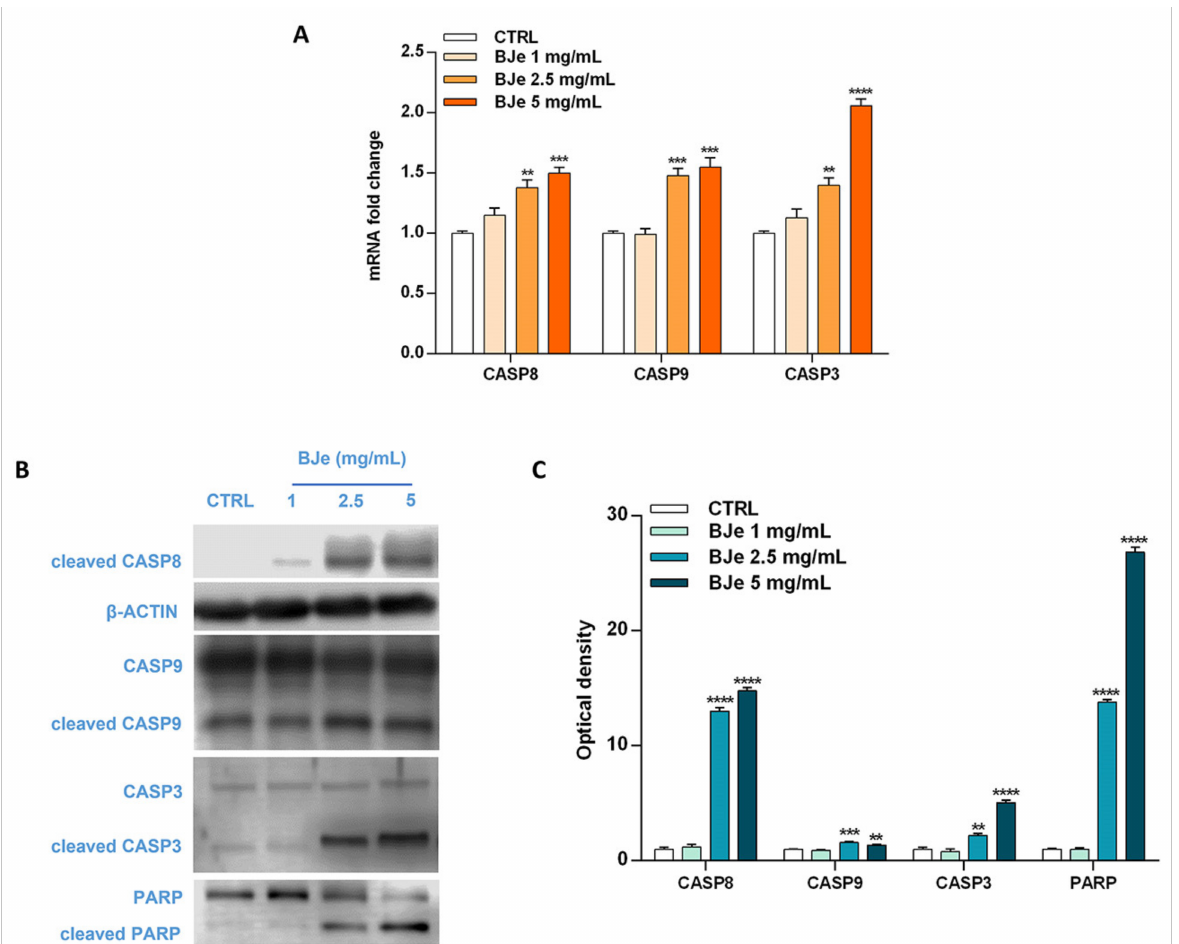
Figure 6. Gene and protein expression of apoptosis-related factors modulated by BJe in THP-1 treated cells. Cells were exposed to different concentrations (1–5 mg/mL) of BJe for 12 h and 24 h and were processed for gene and protein expression studies, respectively. The gene expression was calculated by the 2 – ∆∆ CT method, with β -actin as housekeeping gene. Results are expressed as fold change compared to the untreated cells ( A ). A representative immunoblot of three independent experiments is shown ( B ). Densitometric analysis of bands from three independent blots is presented ( C ). Results are expressed as ratio of the cleaved form with respect to the relative zymogen (cleaved CASP9/CASP9, cleaved CASP3/CASP3 and cleaved PARP/PARP), while the expression of cleaved CASP8 was normalized against β -actin. Protein levels are extrapolated as values detected in the untreated cells (CTRL), which are arbitrarily assigned as 1. Data, represented as mean ± SEM, report the values obtained in three different sets of experiments for Western blotting ( n = 3), while made in triplicate for RT-PCR ( n = 9). ** p < 0.01, *** p < 0.001 and **** p < 0.0001 vs.